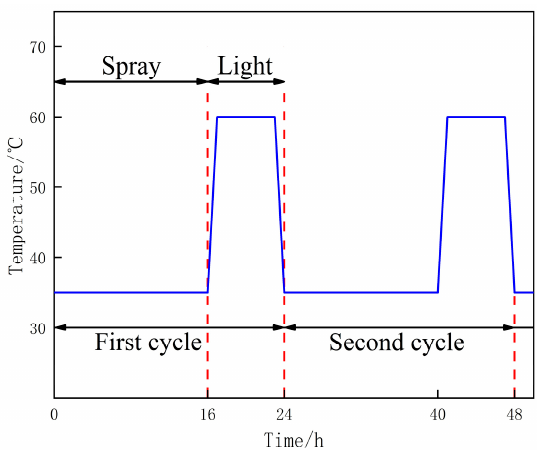
Figure 1. Indoor cycle test chamber.